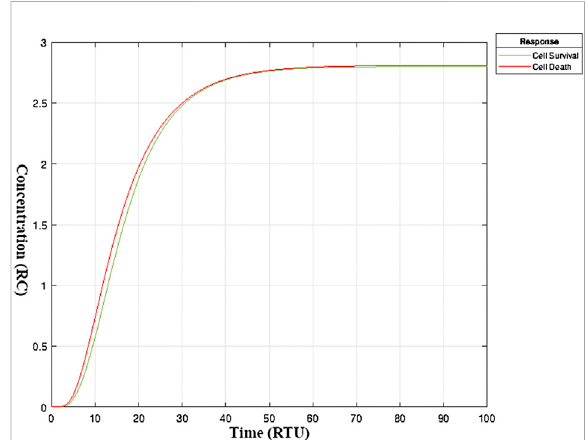
FIGURE 5 BalancedStateofneuronal survivalandneuronalapoptosis in matureneurons-BalancedStateofneuronal survivaland neuronal apoptosis in TNF- α mediated sphingomyelin signaling pathway model under normal circumstances. The y -axis represents the extent or level (in relative concentration) of neuronal survival and apoptosis.The x -axis represents relative time. The two curves, i.e., green and red, are the outcomes of the physiological processes in neurons leading to neuronal survival and death, respectively. The interactive network of signaling pathways keeps neuronalsurvivalandapoptosisinbalance(Koleetal.,2013).Ashift in one or more of these signaling pathways can alter the fate of a neuron resulting inneuronal death or continued survival (Morrison et al.,